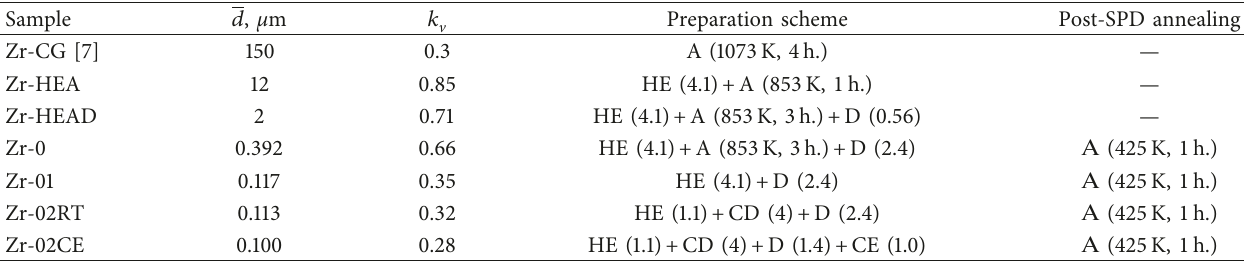
Table 1: Preparation schedules and basic characteristics of the